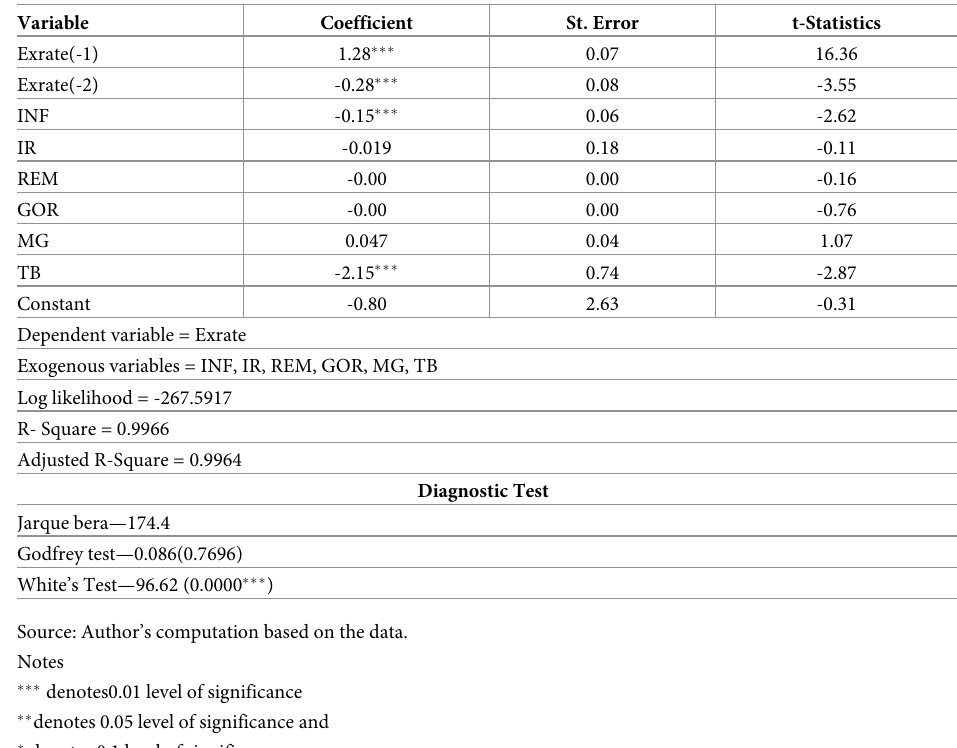
Table 10. Short-run